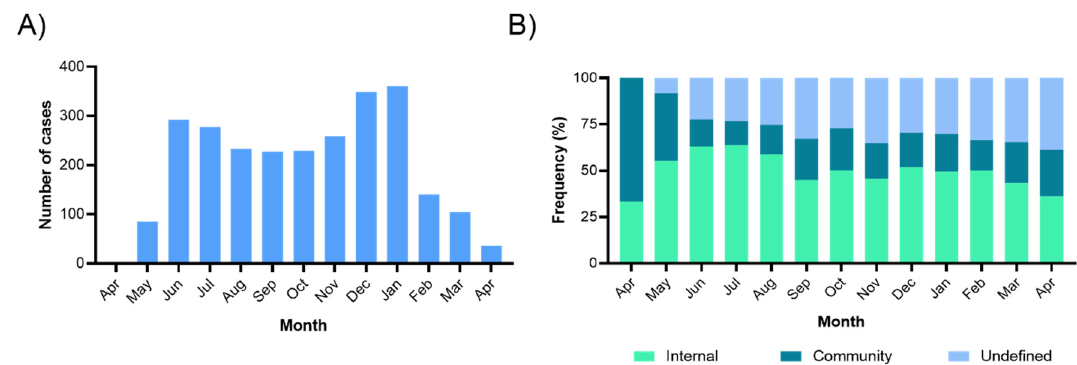
Figure 2. SARS-CoV-2 infection incidence during the first year of the COVID-19 control program implemented in Salud Digna clinics. ( A ) Monthly SARS-CoV-2 incidence in Salud Digna clinics from April 2020 to April 2021; ( B ) Monthly distribution of SARS-CoV-2 incidence by place of contagion: undefined, community (outside clinics), and internal (inside Salud Digna clinics).